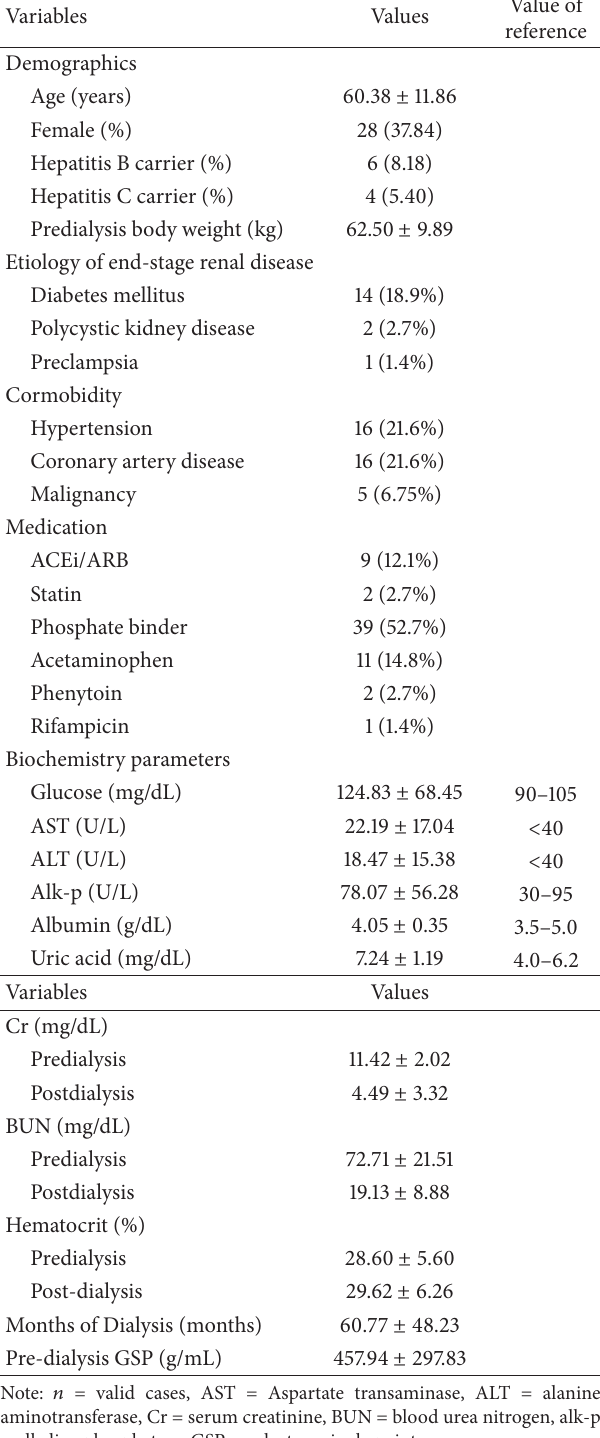
Table 2: Correlation between blood biochemistry parameters and GSP levels.